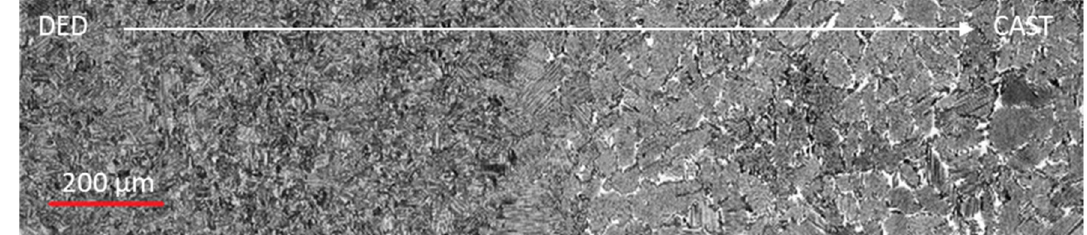
Figure 5. Micro indentation test zone of hybrid γ -TiAl samples. DED (left) and cast (right).